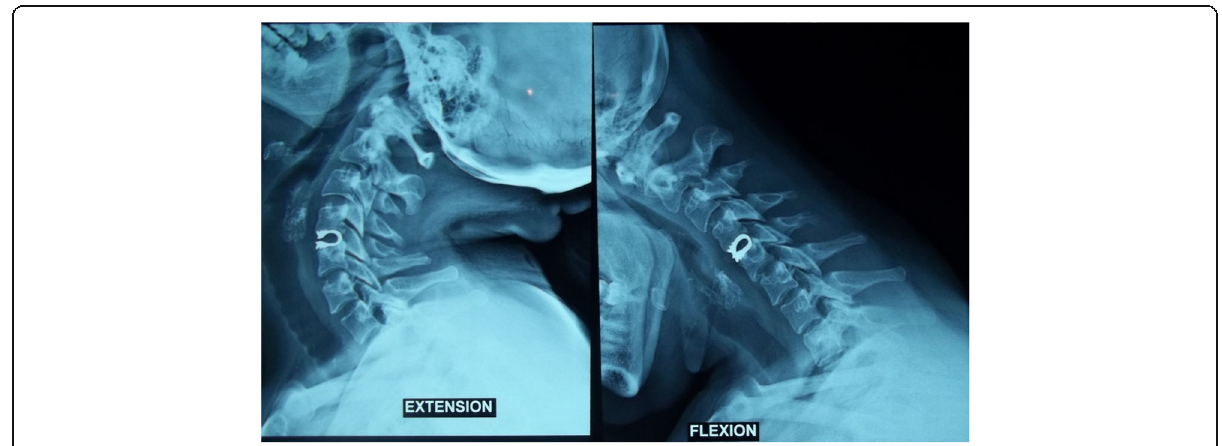
Fig. 9 One year postoperative dynamic cervical plain